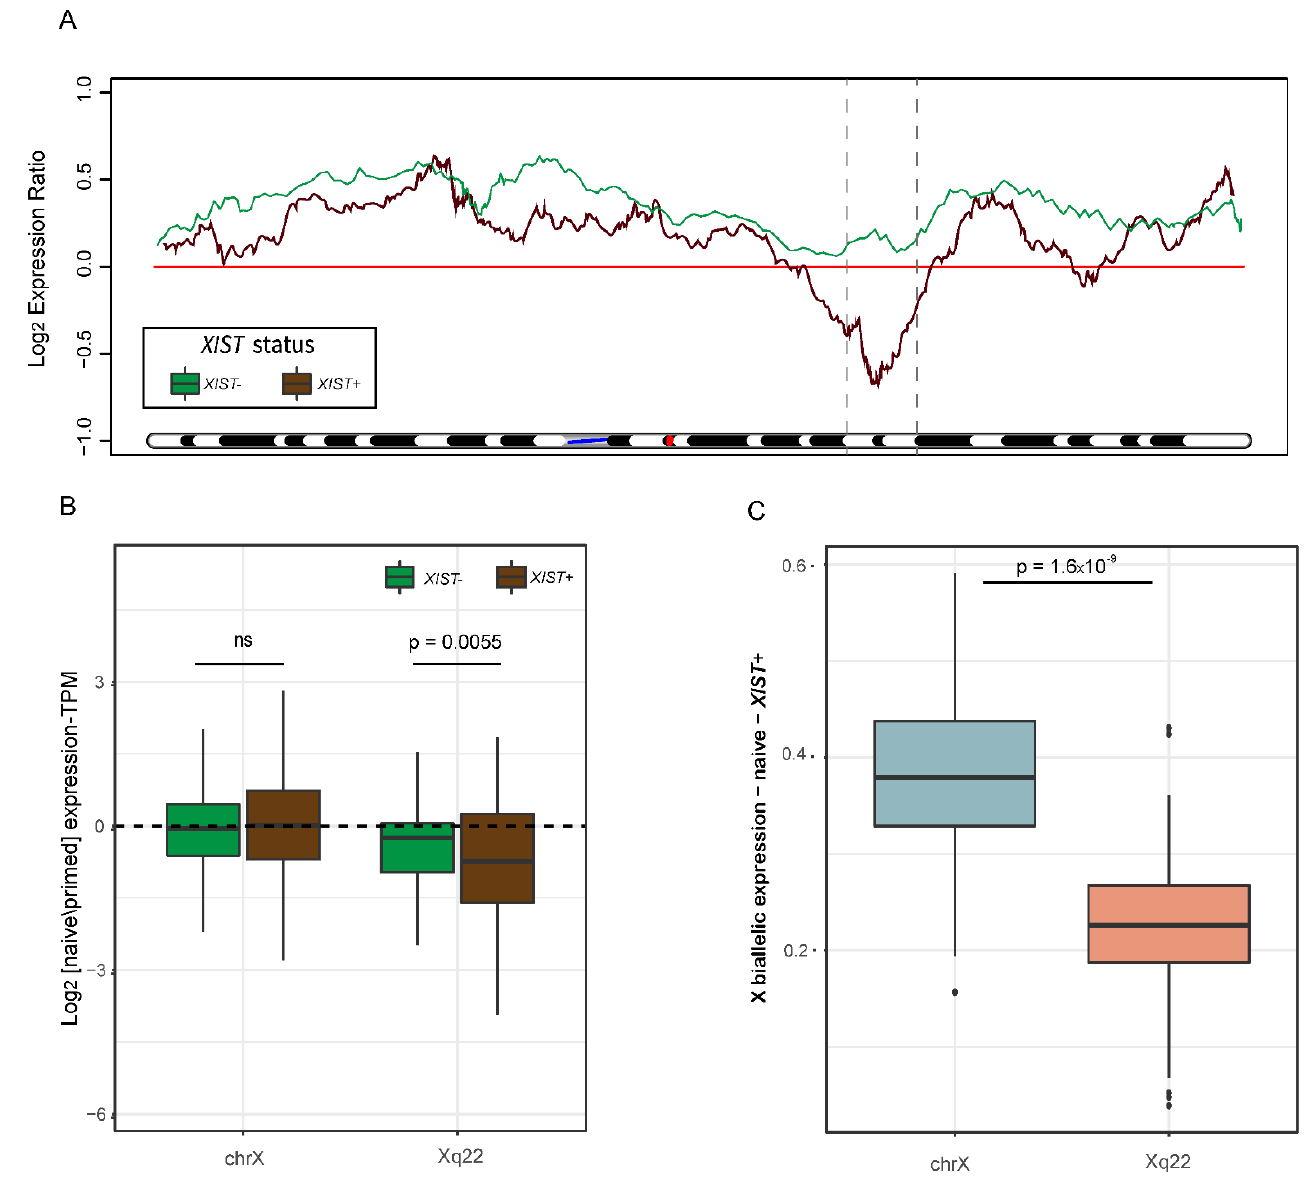
Figure 3. Geographical distribution of gene and allelic expression along chromosome X. ( A ) Moving average plot of median log 2 gene expression naïve/primed ratio along chromosome X, separated into XIST + (brown) and XIST − (green) samples. The blue line marks the location of the centromere, and the red line marks the location of XIST. The dashed lines define Xq22. ( B ) Chromosome X gene expression differences between XIST + and XIST − samples in the entire X chromosome and in Xq22 area. p -value was calculated by a paired t -test. ( C ) X:autosomes allelic ratio in the entire chromosome X (light blue) versus Xq22 region (pink) in XIST + samples. p -value was calculated by a paired t -test.